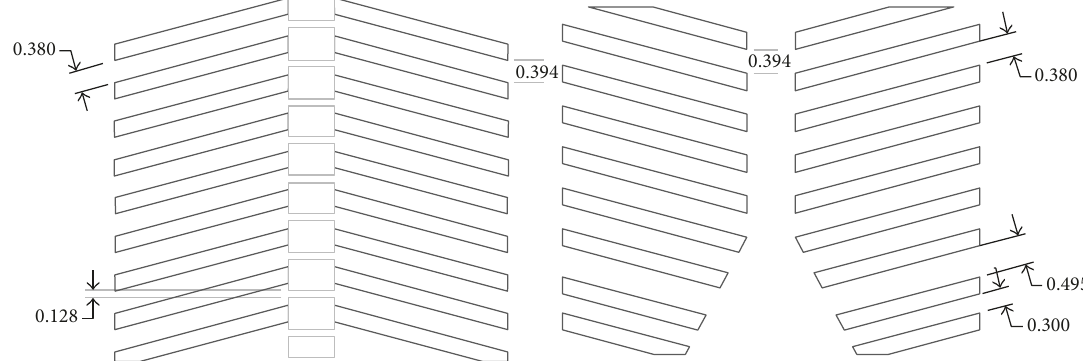
Figure 3: Spacing of BE components in inches. Dimensions of the anterior and posterior rib cage used in the second version of the phantom.